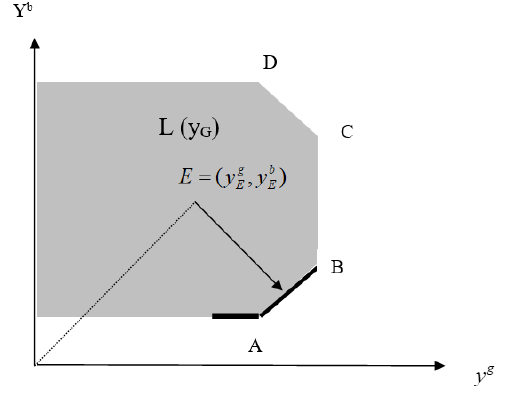
Fig. 2. The graph of the